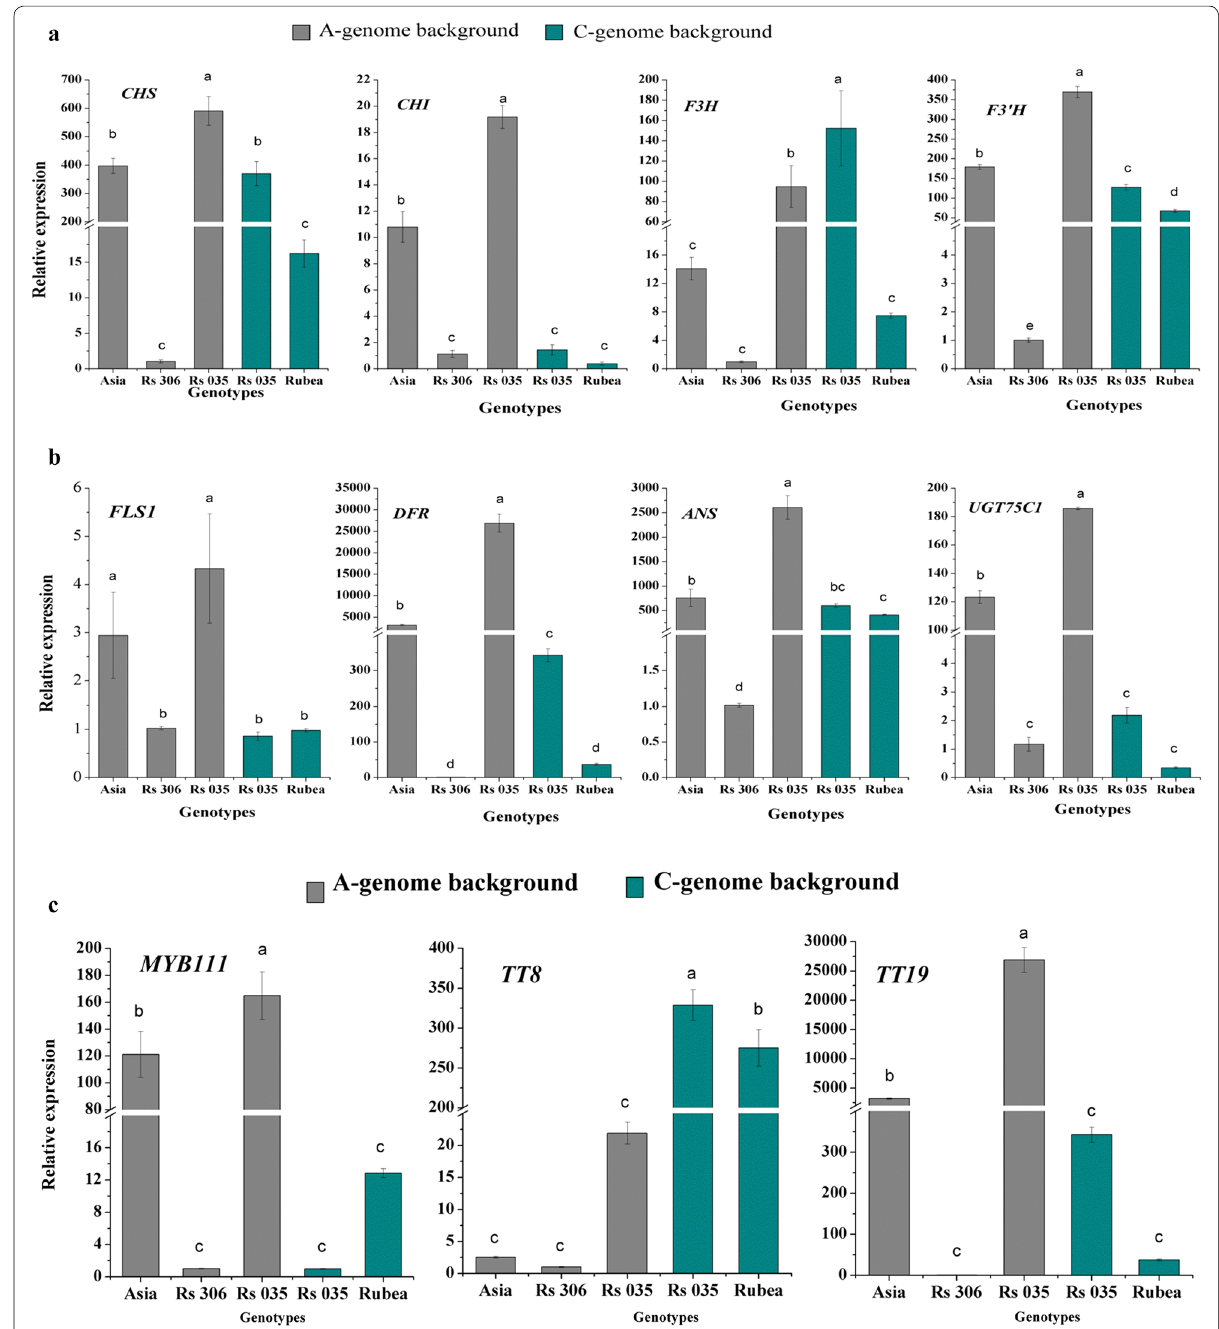
Fig. 4 Expression patterns of the anthocyanin pathway genes. a Upstream structural and biosynthesis genes, b downstream biosynthesis genes, and c regulatory and transporter genes of the A and C genomes, determined using qRT‑PCR with samples of the 4th leaf of 6‑week‑old plants of Asia (donor of A genome), Rubea (donor of C genome), and the resynthesized line Rs035 (red phenotype), with Rs306 (green phenotype) as a control. Error bars represent the standard deviation of the means of three independent replicates for each genotype, while different letters indicate significant differences among the genotypes at p < 0.01, following Tukey’s